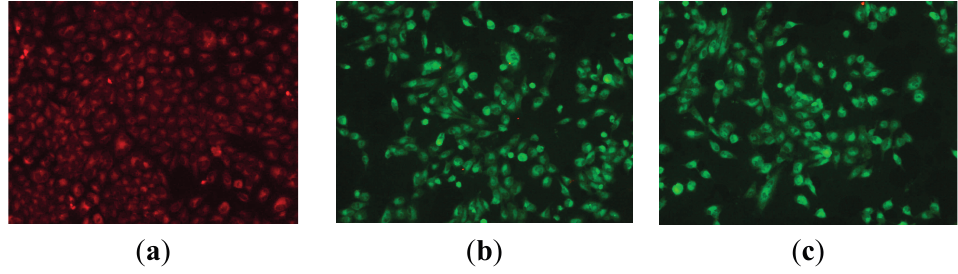
Figure 3. JC-1 mitochondrial membrane potential staining of compound 9n in HeLa cells. ( a ) Cells not treated with the 9n were used as control at for 24 h and ( b , c ) treatment with compound 9n (10 μ M) for 12 and 24 h,